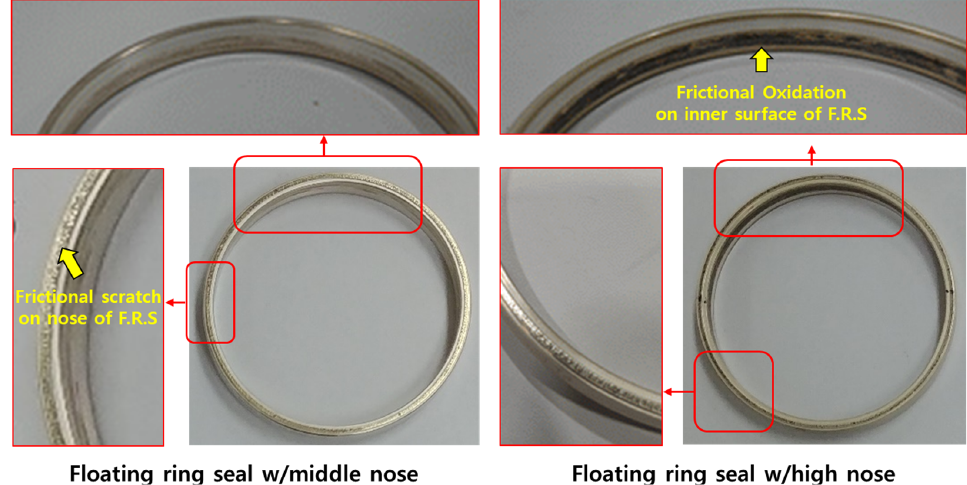
Figure 20. Visual inspection of LOx floating ring seals with change in nose